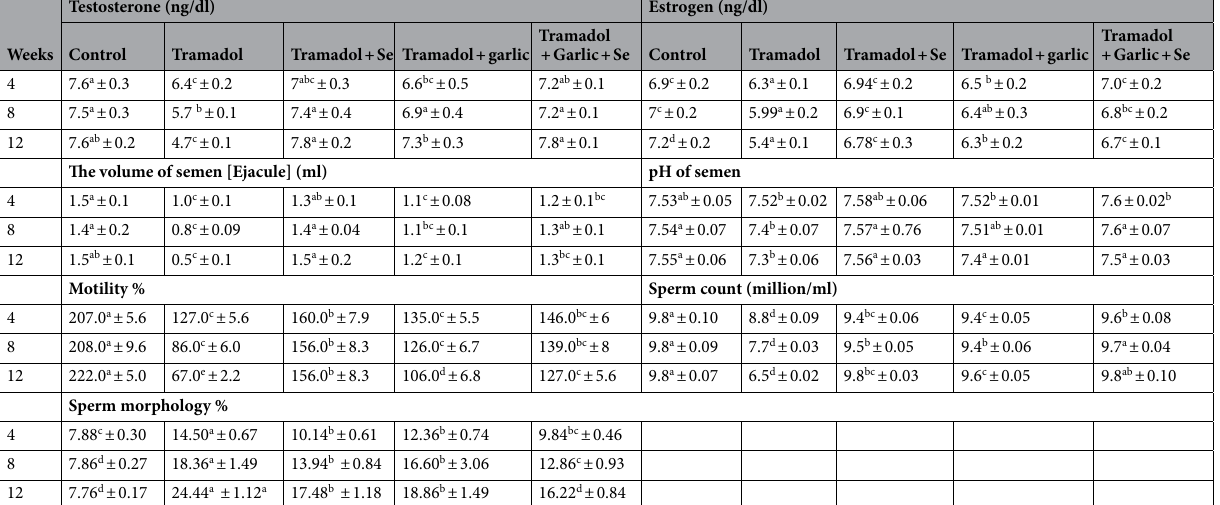
Table 1. Changes in levels of testosterone, estrogen, and semen paramters at 4, 8, and 12 weeks after pretreatment of male rabbits with selenium, garlic, and/or their combination before administration of tramadol by 2 h. All values were presented as the mean and standard error of five rabbits for each treatment. abc Means with different superscript letters were stastiscially significants. abc Means with the same superscript letter were not stastiscially significant. The level of significance for the differences between means was set at P <